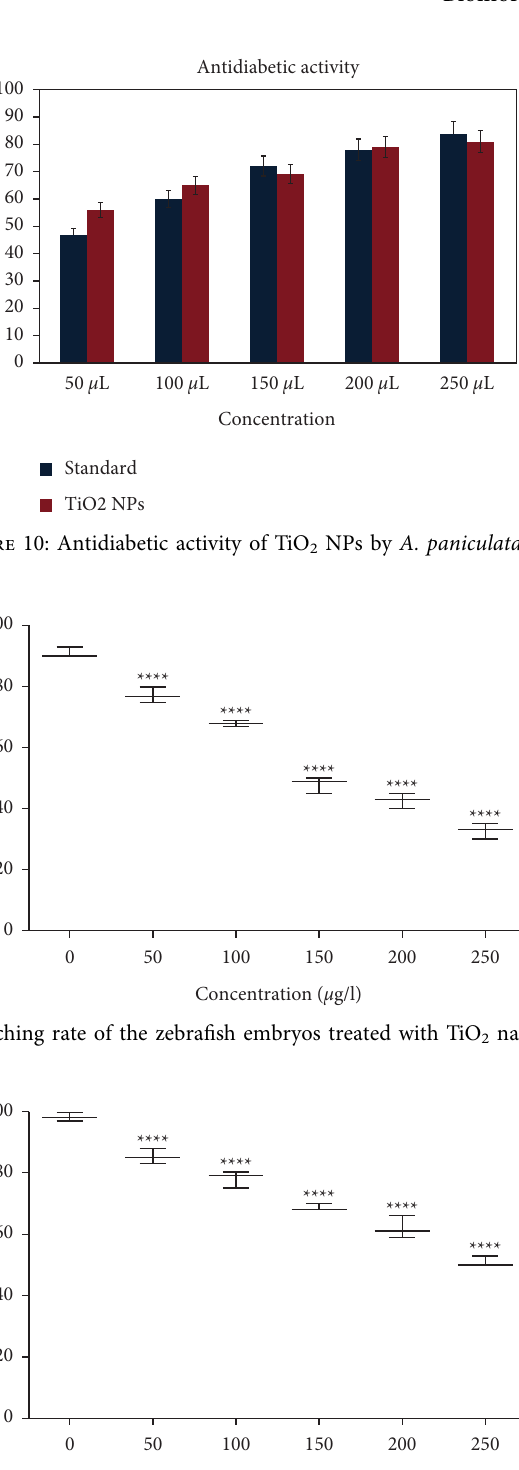
2 nanoparticles.